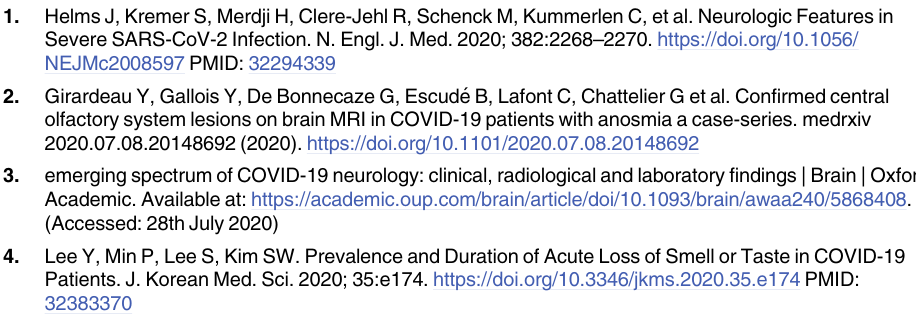
S1 Data. Raw data related to each individual figure. (XLSX) S1 Raw Images. Original, raw, and uncropped images of the Western Blots presented in Figs 1G and